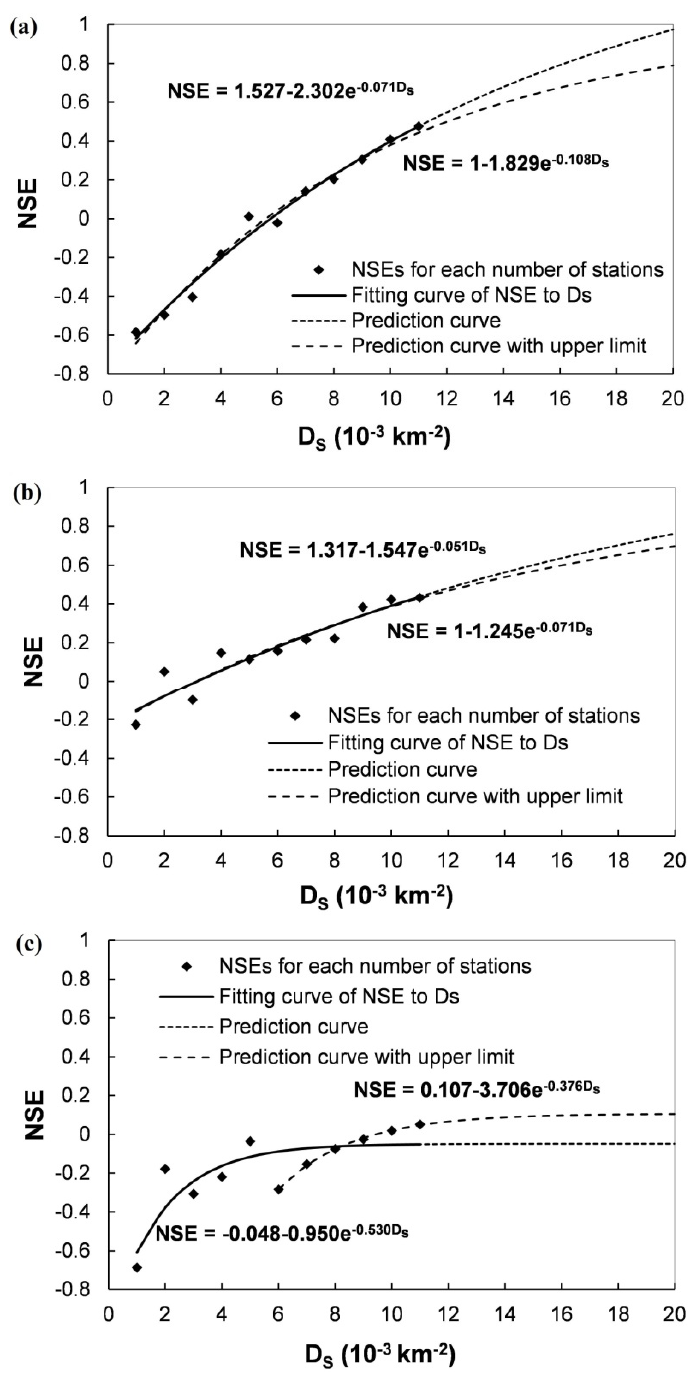
Figure 10. Estimation of the effect of rainfall station density on hydrological simulation events in the upstream of the Qingjian River basin: ( a ) 2001, ( b ) 2002 and ( c ) 2006. The solid lines are the fitting curve between the NSE of simulated runoff and the rainfall station density and the dot dash lines are the prediction if the D S increase. And the dash lines are the predicted NSE values with the upper limit of 1.